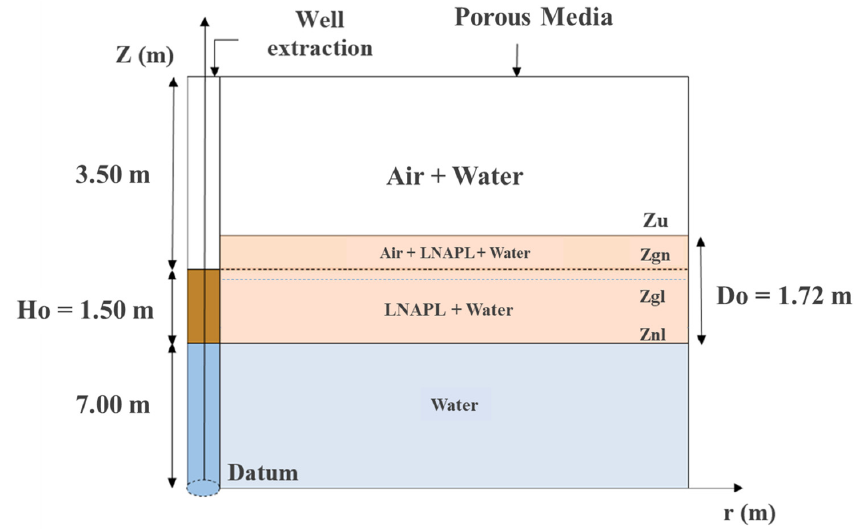
Figure 1. Multiphase extraction (MPE) system conceptual model.